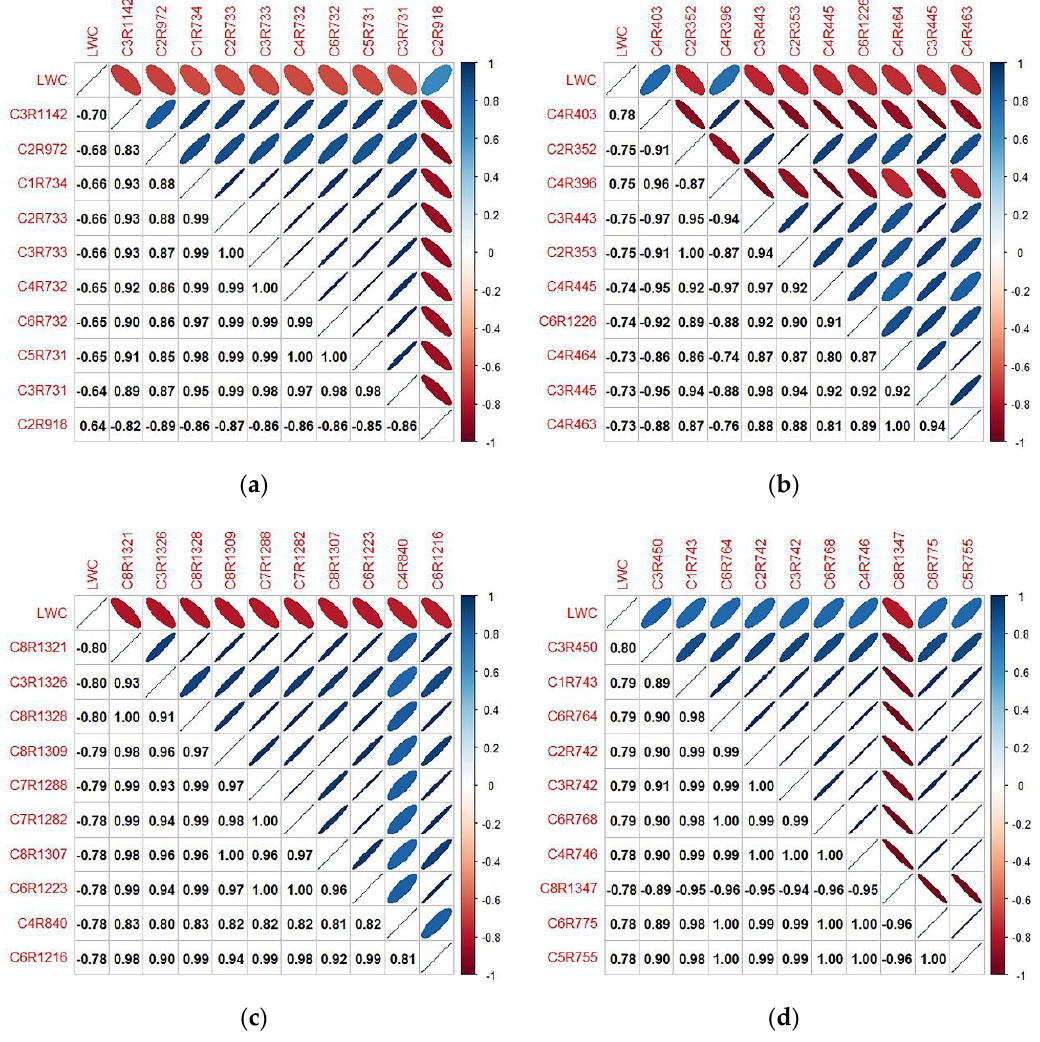
Figure 6. The relevance matrix of the selected wavelet coefficient with LWC in four growth periods. ( a ) Jointing period; ( b ) booting period; ( c ) flowering period; ( d ) filling period.